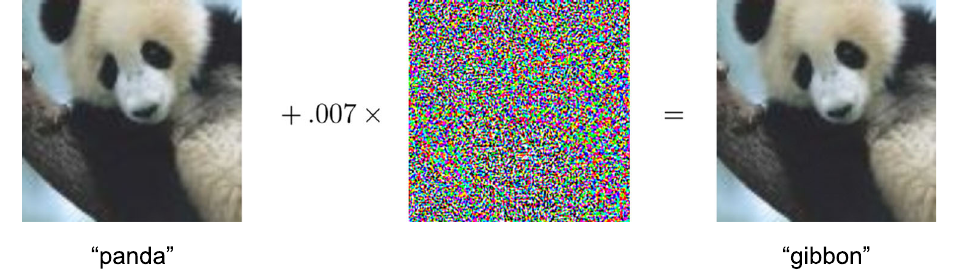
Fig. 15 An adversarial example demonstrated by Goodfellow et al. [61]. A network classified the object in the left image as a B panda ^ with 57.7% confidence. By adding a very small amount of carefully constructed noise (middle image), the network misclassified the object as a B gibbon ^ with